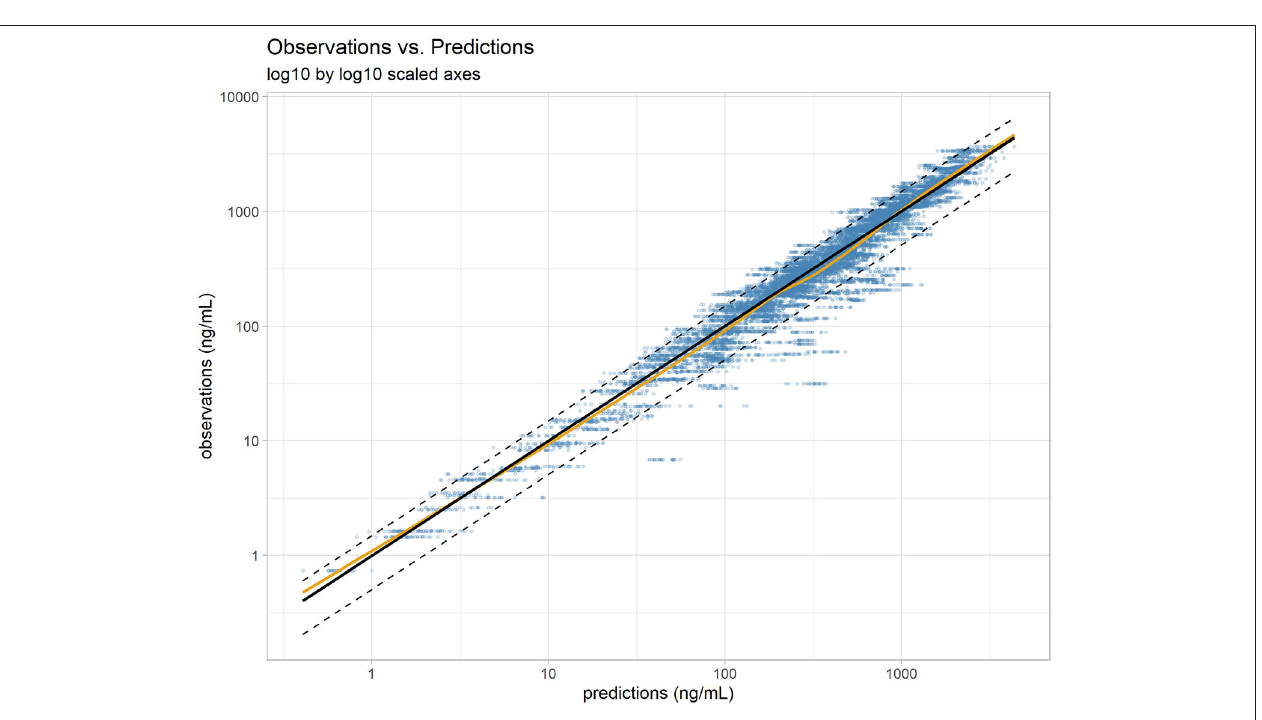
FIGURE 2 | Individual predictions vs. observations. The robustness of fit and predictive performances of the final model were supported by the relatively consistent agreement between observations and individual predictions. Blue dots: observations; black line: identity line; dotted black lines: 90% prediction interval; yellow line: spline. Plotted with log10 by log10 scaled axis to improve ability to compare observations across a large range of